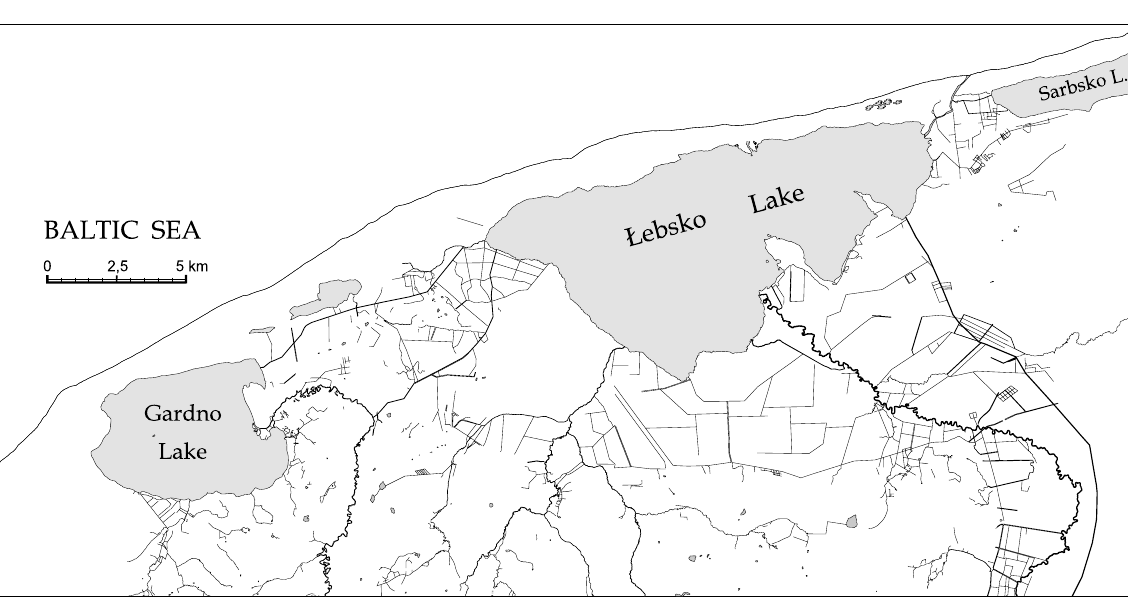
Fig. 2. Hydrographic network of Gardno-Łeba Lowland in the early 19th